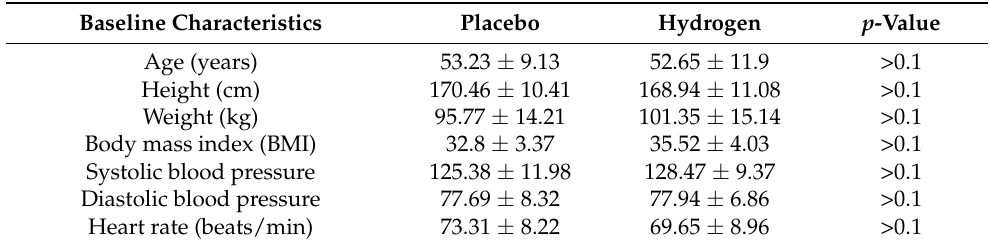
Table 1. Baseline characteristics of